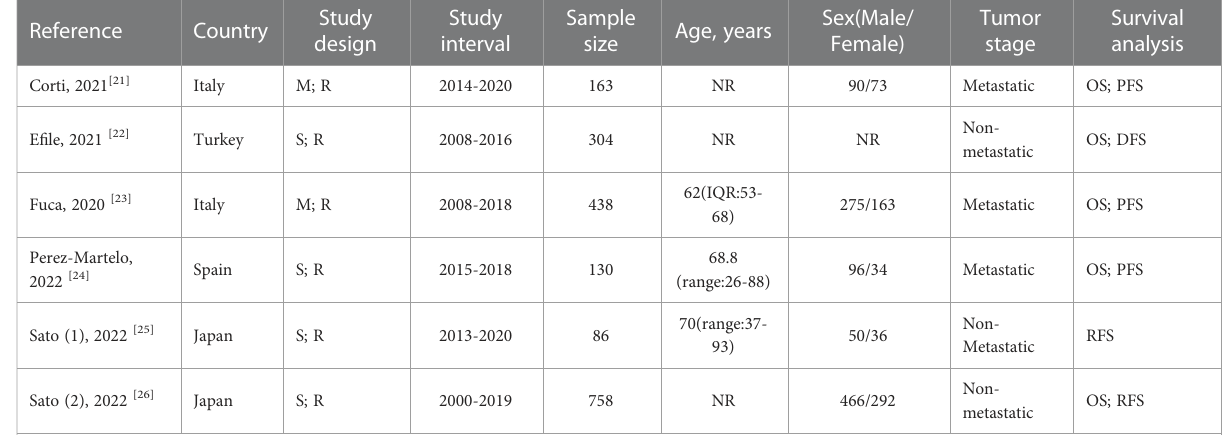
TABLE 1 Basic information of included